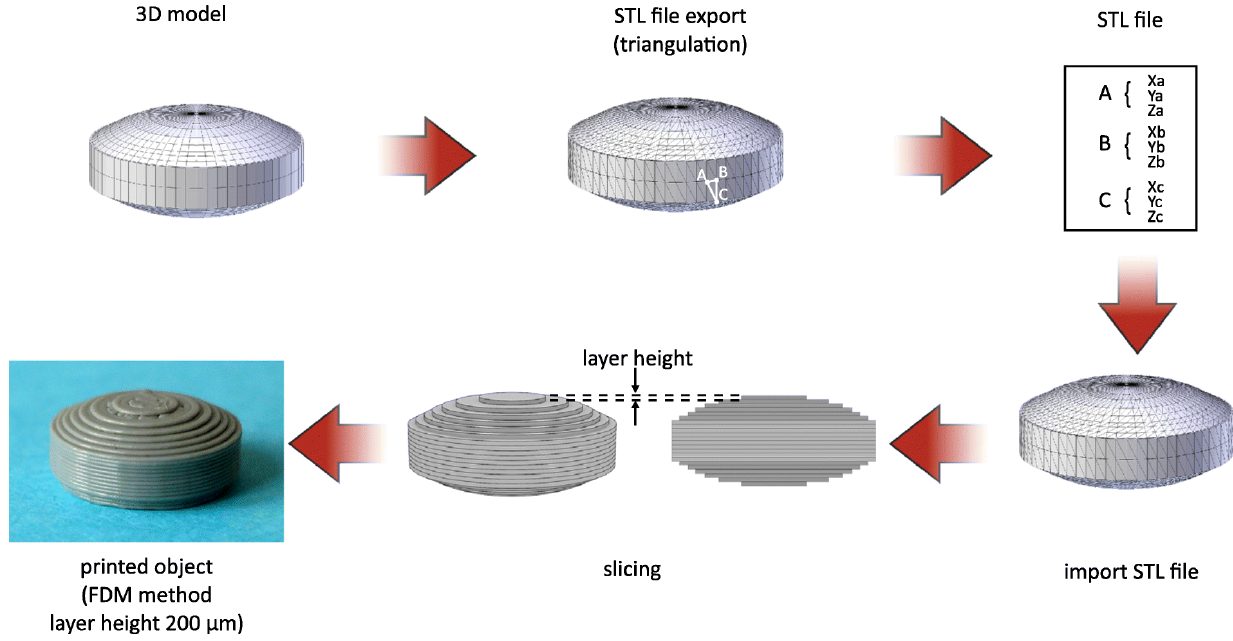
Figure 6. 3D-Printing phases to realize a printlet by FDM method. Reprinted from reference [1].